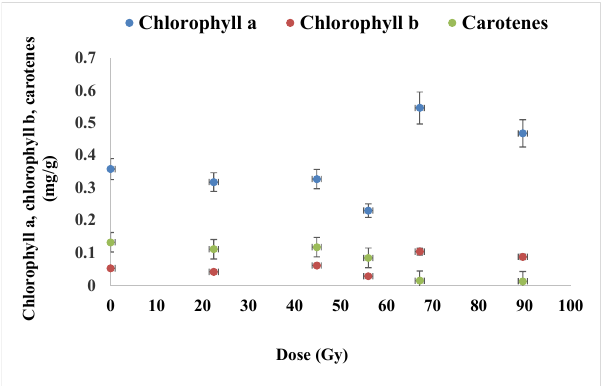
Figure 8. The influence of proton beam at the Bragg peak on the photosynthesis pigments. Three repetitions of the photosynthesis pigment assay were carried out for each experimental variant. It is important to also comment the ratio of the chlorophyll contents (Figure 9) as this is taken as indicator of photosynthesis efficacy. This parameter was found to decrease clearly in the samples corresponding to the proton irradiation, with up to 25% for the highest radiation dose range used in this experiment (around 90 Gy) that suggested the impairing of the photosynthesis system PSII hosting enzyme systems involved in the photosynthesis complex process. One could associate these results with the hypothesis of radiation genotoxic effect in the irradiated seeds where possibly certain genes were af- fected and so the corresponding enzymes from cell chloroplasts.